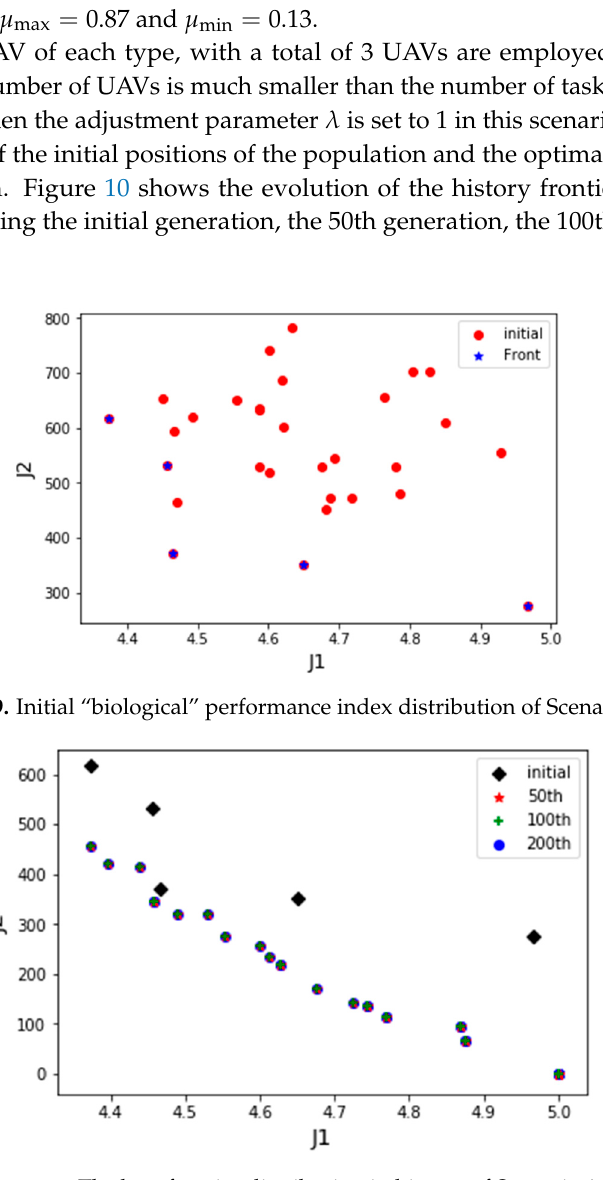
Figure 10. The best frontier distribution in history of Scenario 1.